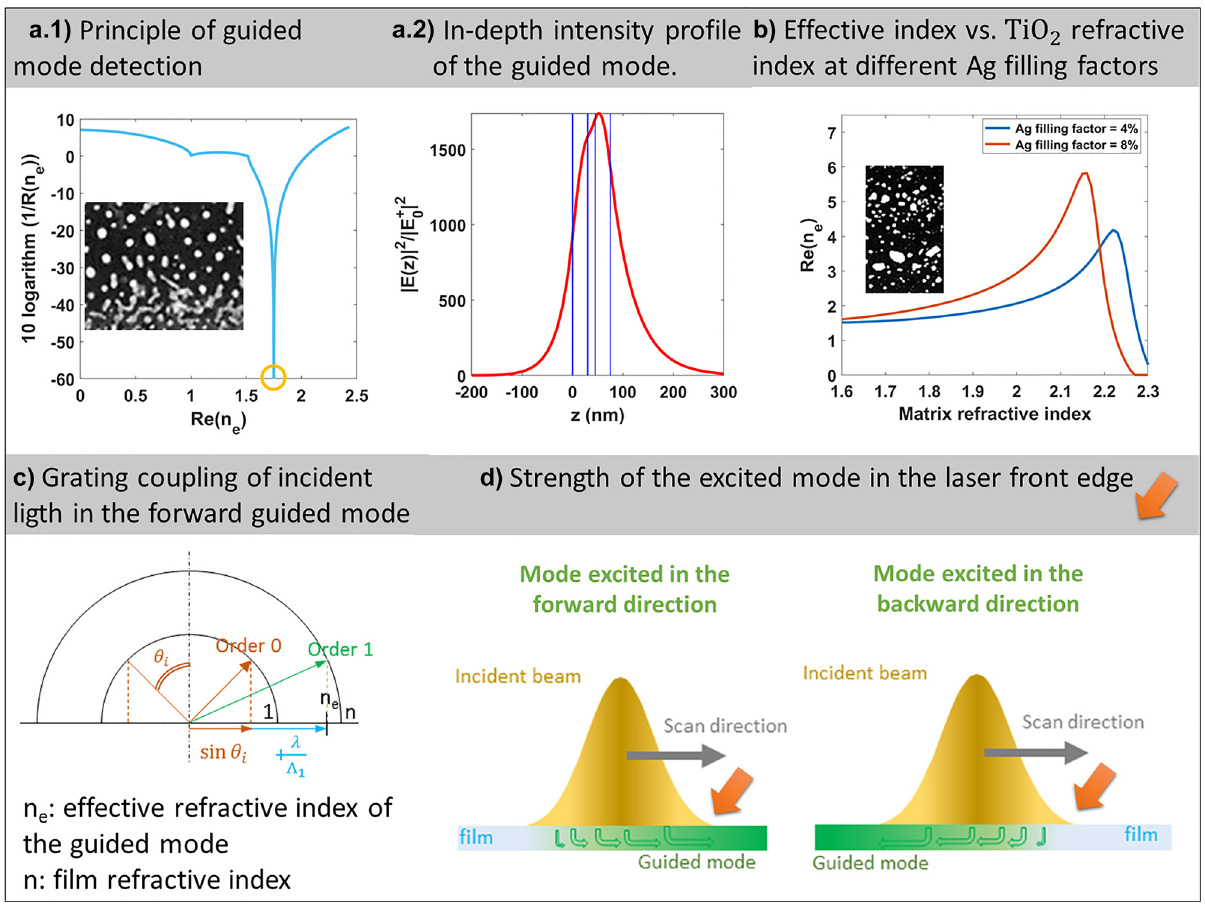
Figure 4: Optical mechanisms involved in the formation of self-organized periodic nanopatterns (a.1) Inverse of the reflection factor after N eff =58(insetfromFigure2).Itexhibitsaminimumforaparticularrealpartoftheeffectiveindexofthestructure.Theparametersof thelatter are de fi ned from the HAADF-STEM characterizations. The presence of a minimum means that a mode with the corresponding effective index (highlighted by the yellow circle) can be guided in the structure. (a.2) Intensity pro fi le of the corresponding guided mode as a function of the depth inside the multilayer stack. Blue vertical lines indicate the interfaces of the sample with z = 0 nm being the air/TiO 2 interface. (b) After 50,000 pulses (inset, sameas in Figure2), Ag nanoparticles progressively diffuseinthe TiO 2 whose layersmerge ina single layer. Calculation oftheeffectiveindexoftheguidedmodefortwovolumefractionsof